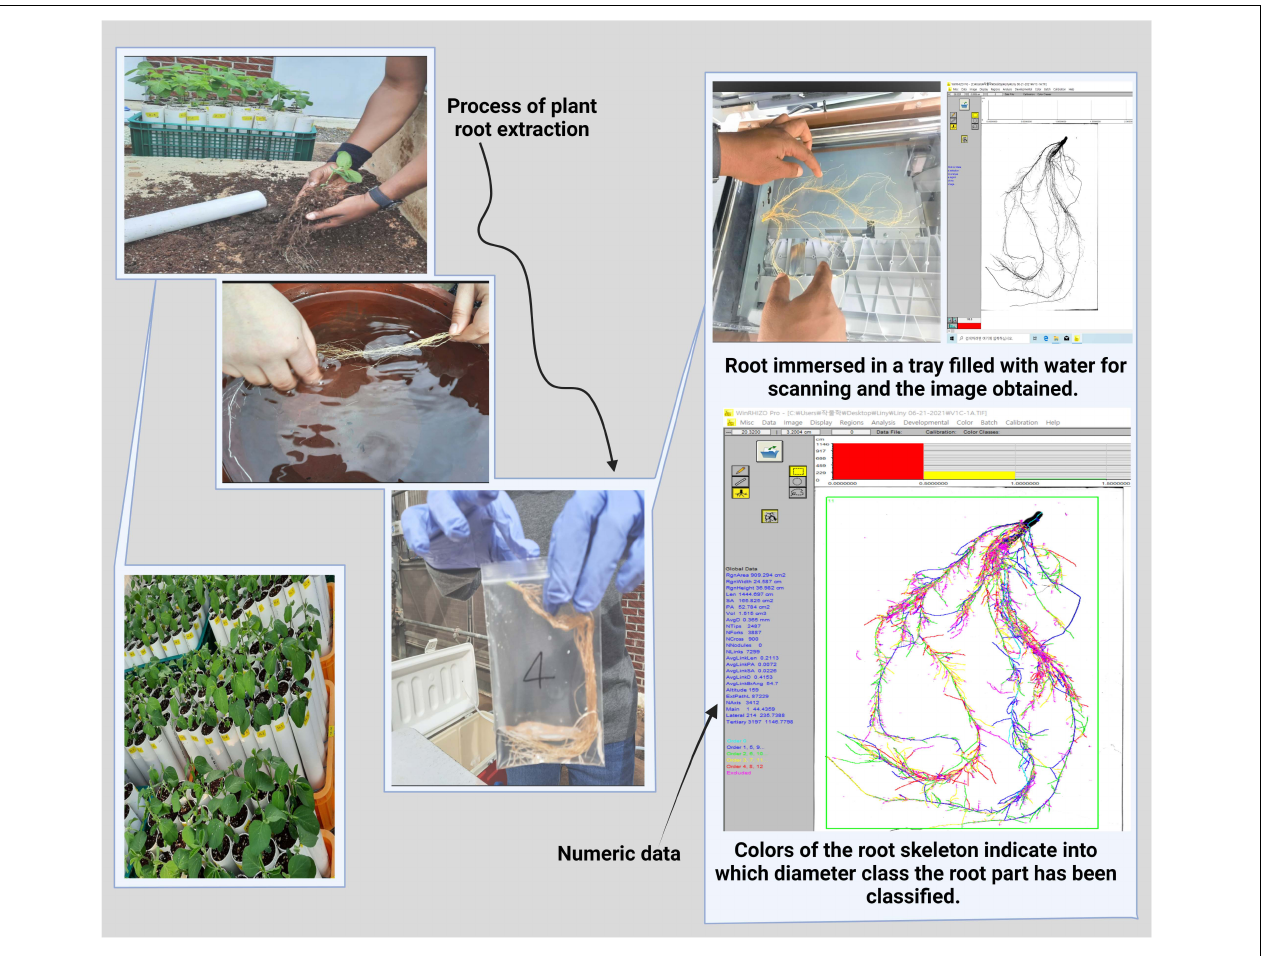
FIGURE 1 | Process of root analysis for morphological data